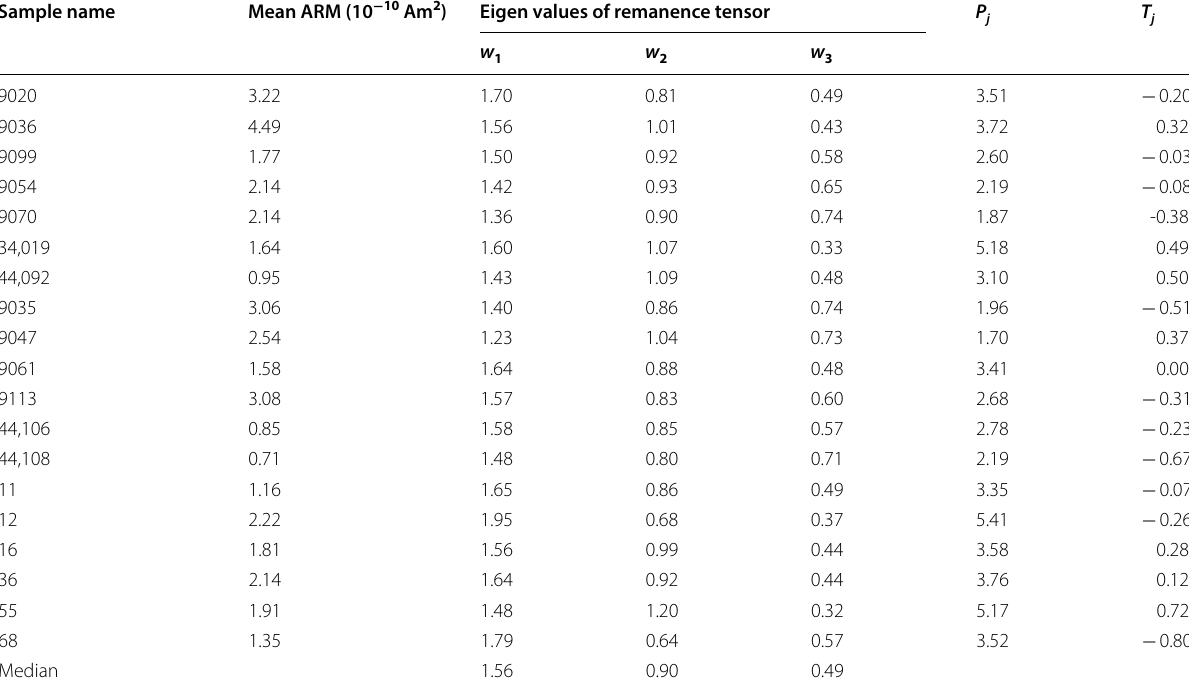
Mean ARM average of the eigenvalues of ARM anisotropy tensor, w 1 , w 2 and w 3 maximum, medium and minimum eigenvalue of ARM anisotropy tensor normalized by the mean